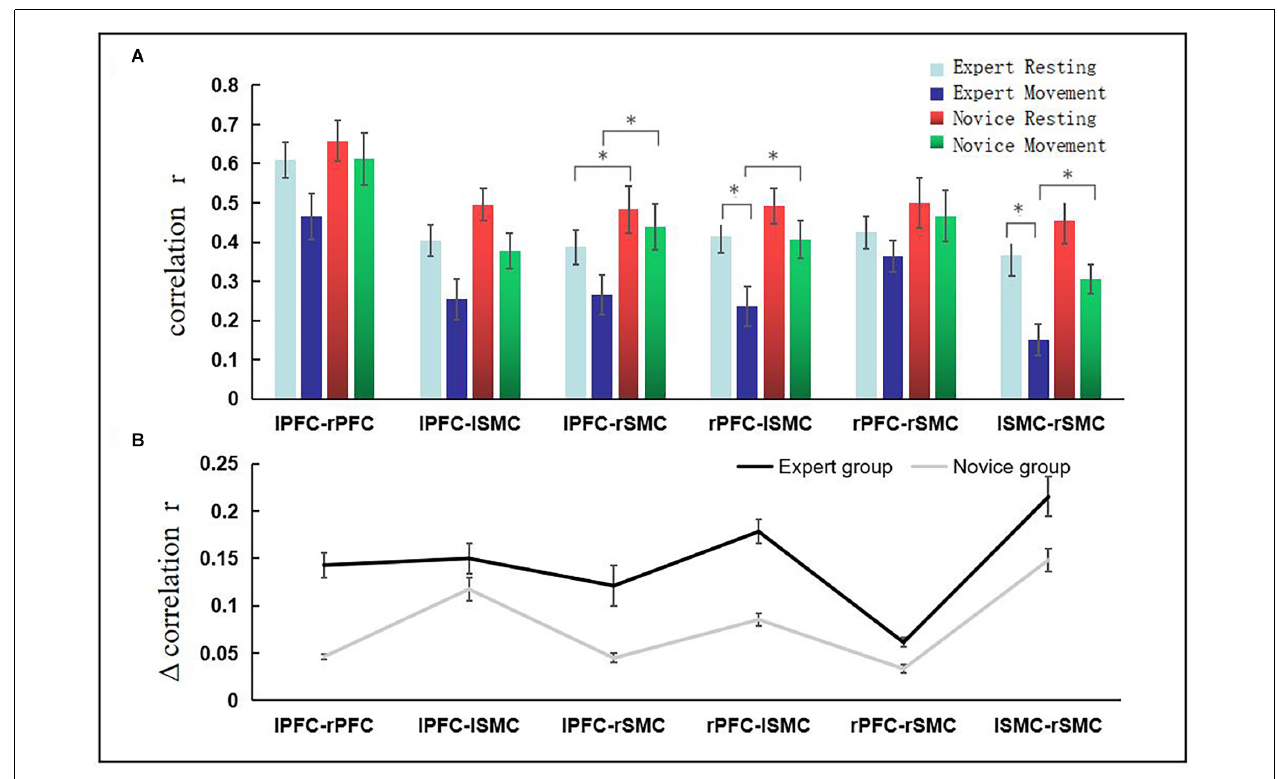
FIGURE 4 | The increment of functional connection intensity of brain interval from resting state to exercise state. Panel (A) ∗ ( P < 0.05) revealed significant differences across ROIs. The abscissa represents the brain area, the ordinate represents the correlation coefficient, the light blue bar represents the resting state of the expert group, the dark blue bar represents the exercise state of the expert group, the red bar represents the resting state of the novice group, and the green color bar indicates the movement state of the novice group. (B) The absolute value of functional connectivity (r-value) change is represented from the resting state to the exercise state in each group. Error bars represent standard errors. The black line indicates the expert group, and the gray line indicates the novice